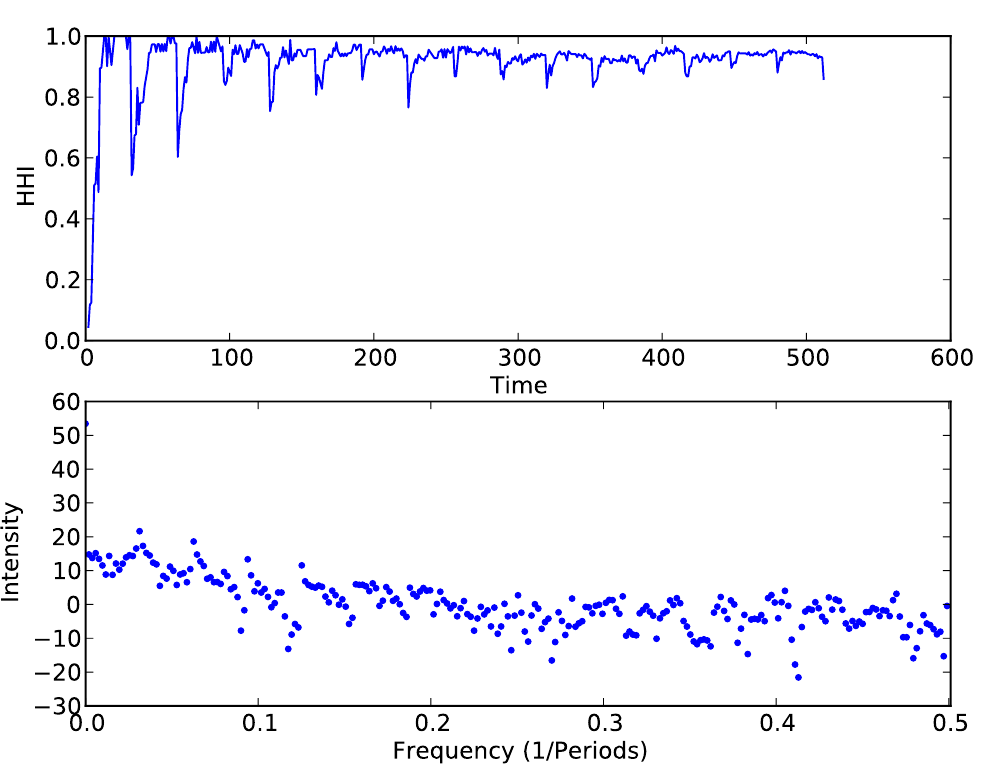
Figure 10. Development of the heterogeneity of the population (with respect to adherence to institutions) measured by the Herfindahl-Hirschman Index and the frequency spectrum of the Herfindahl Index time series for ↵ = 1 . 1 (see, also, figure